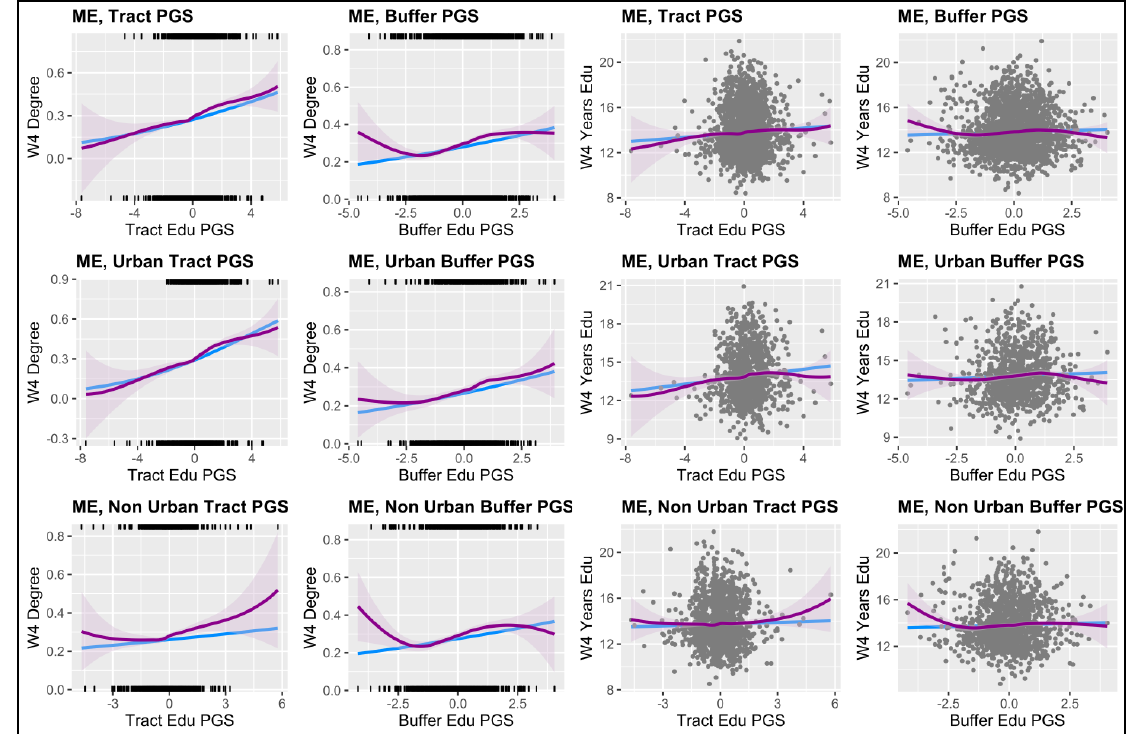
Figure5: Visualized regression lines for mixed-effects (ME) results on tract- and buffer-based average education PGS predicting education (whether attained a college degree and years of completed education) in wave 4. Regression lines (blue for linear, purple using Loess smoothing) are consistent with the estimates contained in Table 5 and produced using the visreg package in R (see Breheny and Burchett [2017]). Edu, education; W4, wave